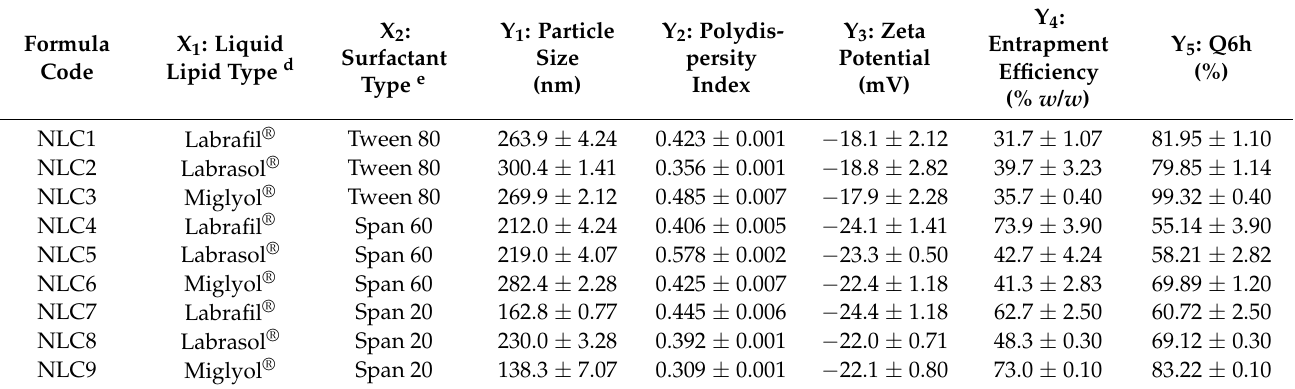
Table 2. Experimental runs, independent variables and measured responses of ZMP-loaded NLCs following a 3 2 full factorial design a,b,c